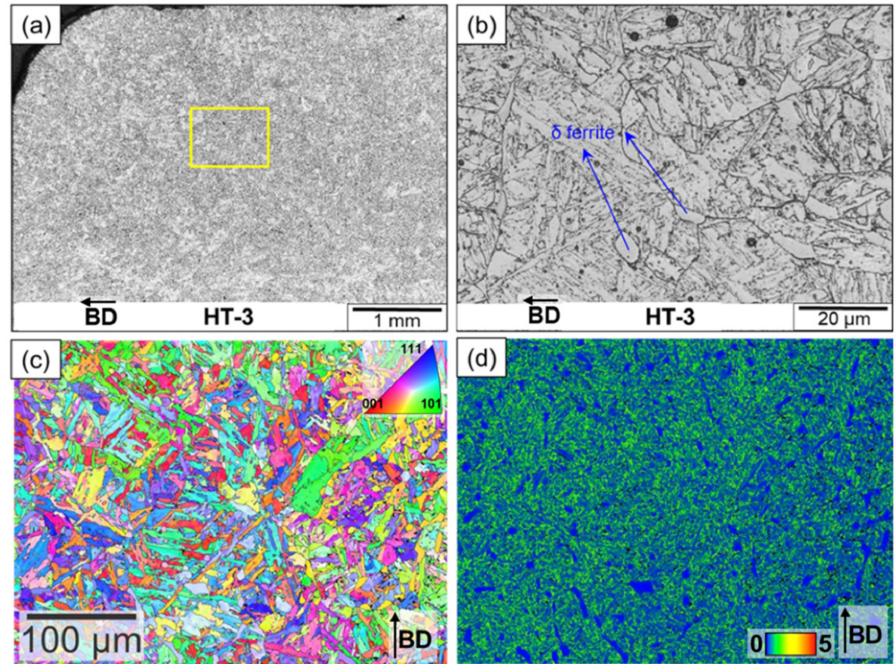
Figure 14. Characterization of the samples after PPHT (HT-3 treatment) ( a , b ). Optical micrographs showing a tempered martensitic structure with sporadic delta ferrite stringers ( c ). Inverse pole figure ( d ). Kernel average misorientation maps indicate the presence of delta